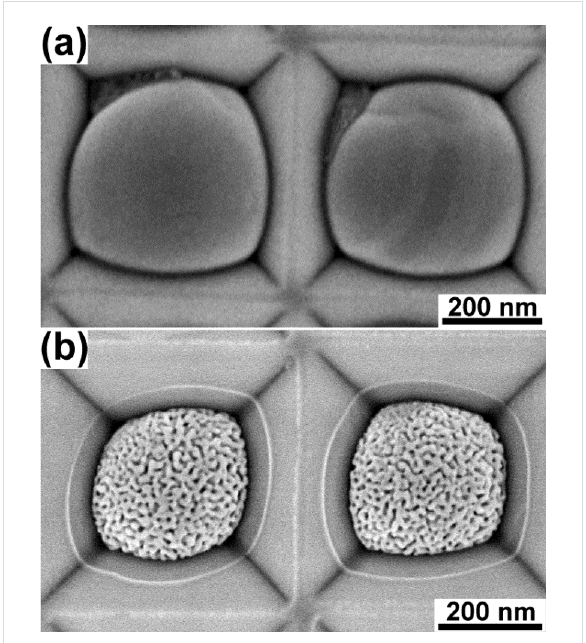
Figure 2: SEM micrographs of samples before and after dealloying: (a) ordered array of Au–Ag alloy nanoparticles dewetted from the 15 nm Au/30 nm Ag bilayers, and (b) ordered array of nanoporous gold nanoparticles formed after the subsequent